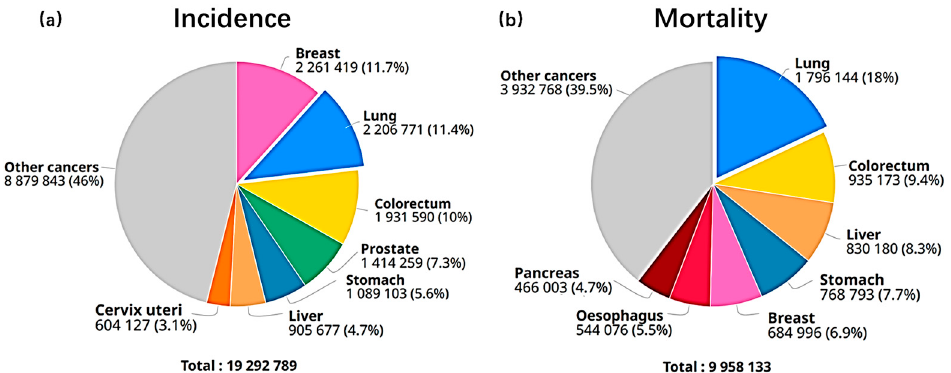
Figure 1. Global major cancer statistics (in 2020, the world, both sexes, all ages). ( a ) The type, number, and proportion of new cancer cases; ( b ) the type, number, and proportion of cancer deaths. Reproduced with permission from Ref. [2], © 2023 American Cancer Society.